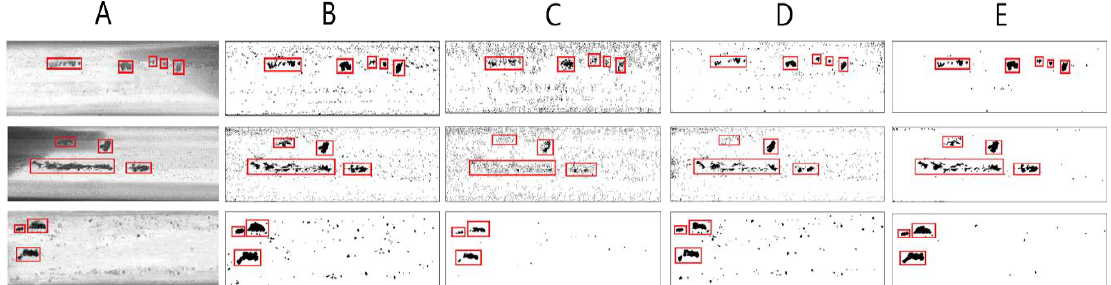
Figure 11. Examples of four defect segmentation methods for rail surface images. ( A ) Three examples of extracted rail images. ( B ) Three examples of defect segmentation by LWLC+ME method. ( C ) Three examples of defect segmentation by LWLC+GSTA. ( D ) Three examples of defect segmentation by MLC+PEME method. ( E ) Three examples of defect segmentation by LWLC+GSME method. In Figure 10, the discrete defects on images have been marked by red rectangle to compare enhancement performance of LWLC+GSME method with related methods.